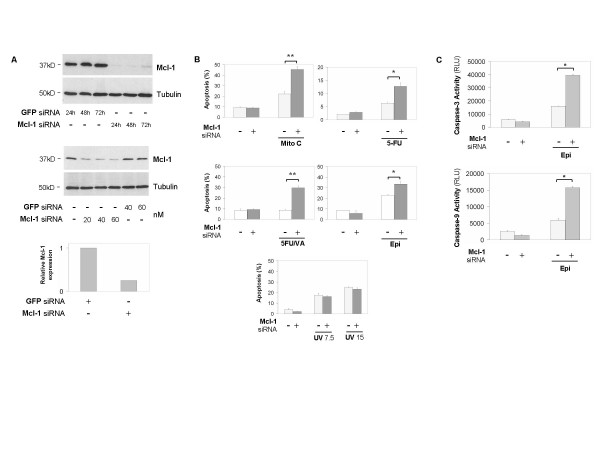
Silencing of Mcl-1 expression in HCC cells by RNA interference results in sensitization towards chemotherapy. (A) Huh7 cells were transfected with siRNA specific for Mcl-1 (40 nM) or transfected with siRNA specific for green fluorescent protein (GFP) as control. Cells were lysed 24, 48 and 72 h after transfection and analyzed for Mcl-1 expression by Western Blot (upper panel). Tubulin expression was used to control equal loading. siRNA concentration was titrated as indicated and expression of Mcl-1 and tubulin was analyzed by Western Blot 24 h after transfection (middle panel). 24 h after transfection with siRNA (40 nM), total RNA was extracted and analyzed for Mcl-1 mRNA expression by quantitative real-time PCR (lower panel). Expression of Mcl-1 was normalized to actin in each sample. Relative Mcl-1 expression was calculated as described in the materials and methods section. (B) Huh7 cells were transfected with siRNA specific for Mcl-1 (40 nM, "Mcl-1 siRNA +") or transfected with siRNA specific for GFP as control ("Mcl-1 siRNA -"). 24 h after transfection cells were treated with different chemotherapeutic drugs for 24 h (mitomycin C, 10 μM, 5-FU, 150 μg/ml (with or without valproic acid, VA, 100 μg/ml) and epirubicin, 1 μg/ml). Some cultures were irradiated with UV (7.5 and 15 mJ/cm2, respectively). 24 h later, cells were harvested and analyzed by flow cytometry for apoptosis induction according to the method by Nicoletti [29]. Assays were performed in triplicates and are representative for at least three independent experiments. Values are means + SD. *p < 0.01, **p < 0.001. (C) Cells were incubated for 24 h with epirubicin (1 μg/ml). Caspase-3 (upper panel) and caspase-9 (lower panel) activity were measured by fluorometric assays as described in the materials and methods section. Bars = SD.